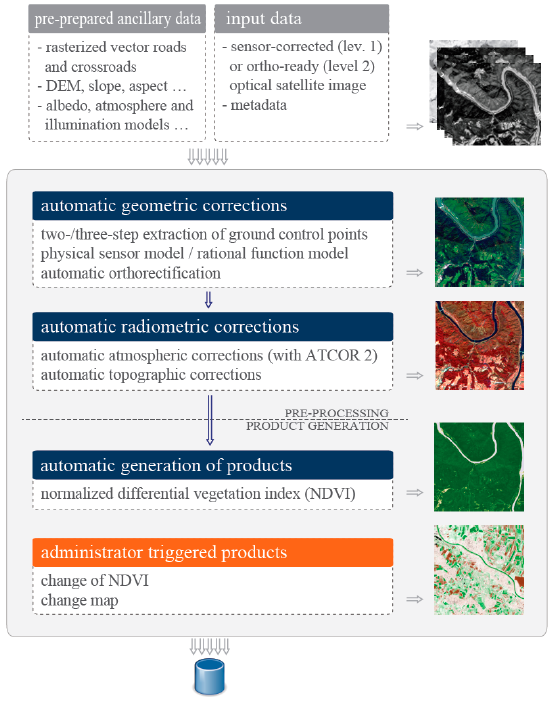
Figure 1. Processing workflow of the STORM processing chain.